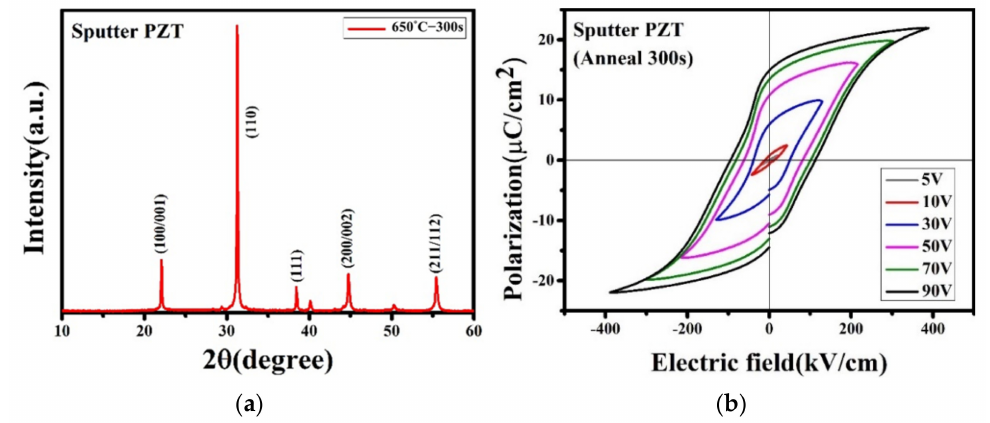
Figure 7. Properties of the sputtered PZT: ( a ) XRD pattern; ( b ) P-E hysteresis loop.